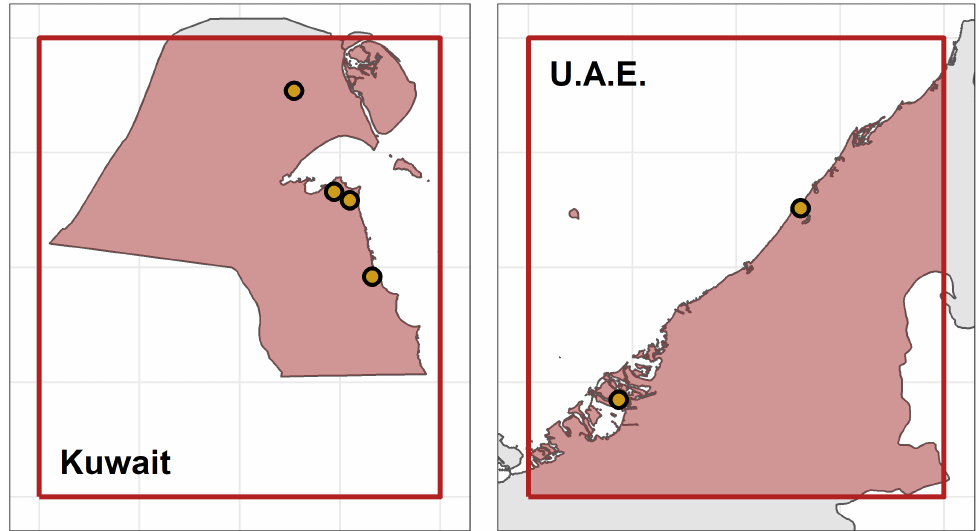
Figure 2. Areas within each country where temporal and spatial autocorrelations for MAIAC AOD were evaluated (shaded pink) and the PM 2.5 monitors (yellow circles) in each